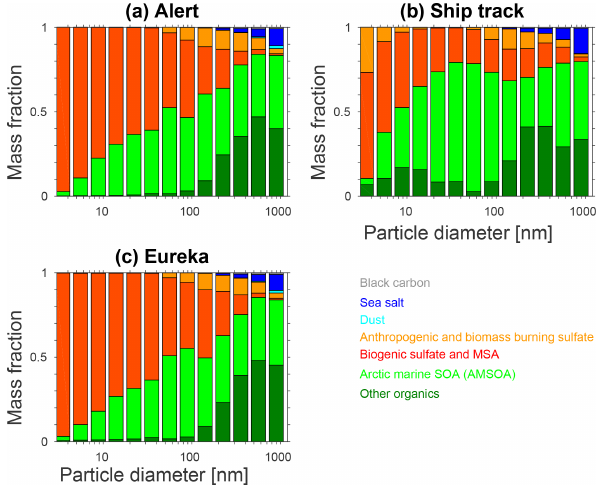
Figure 8. Simulated summertime- (July and August 2016) mean size-resolved aerosol component mass fractions for (a) Alert, (b) the Amundsen ship track, and (c) Eureka, for the BASE + TUNDRA + BIRDS + 100xnuc + AMSOAnv/sv simulation as described in Table 1 and Sect. 2.3. Other organics includes all organic aerosol except the AMSOA. Biogenic sulfate includes all sulfate derived from the oxidation of